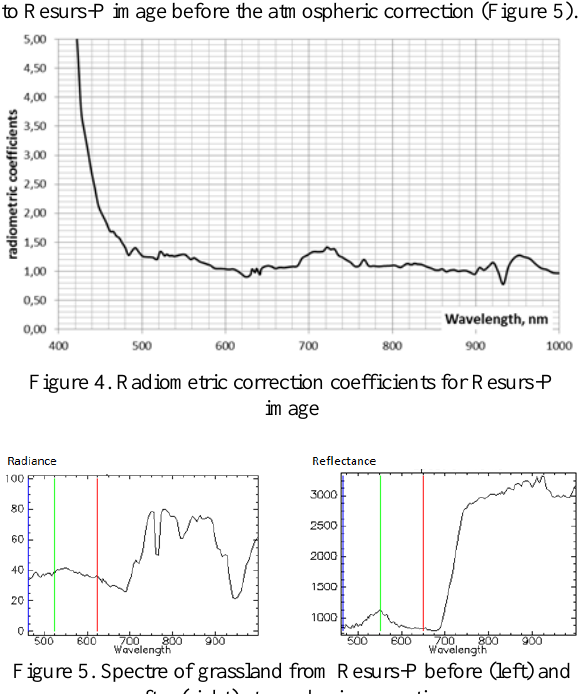
Figure 5. Spectre of grassland from Resurs-P before (left) and after (right) atmospheric correction